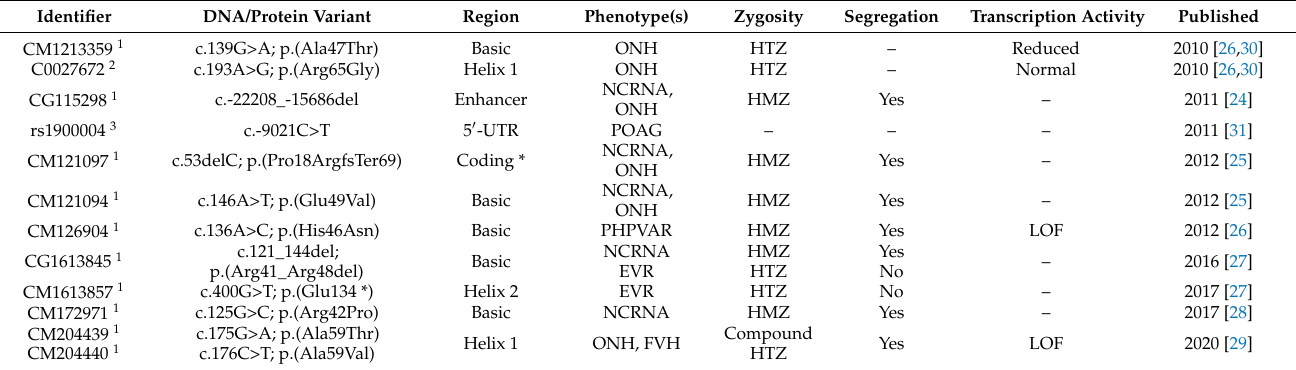
Table 1. List of published ATOH7 variants and associated phenotypes. Note that the heterozy- gous variants do not show a clear genotype–phenotype relationship. Transcription activity refers to whether the protein induces transcriptional activation of a reporter gene in luciferase assays. ATOH7 , atonal bHLH transcription factor 7; dbSNP, single-nucleotide polymorphism database; EVR, exudative vitreoretinopathy; FVH, foveal hypoplasia; HGMD, human gene mutation database; HMZ, homozygous; HTZ, heterozygous; LOF, loss of function; NCRNA, nonsyndromic congenital retinal nonattachment; ONH, optic nerve hypoplasia; PHPVAR, autosomal recessive persistent